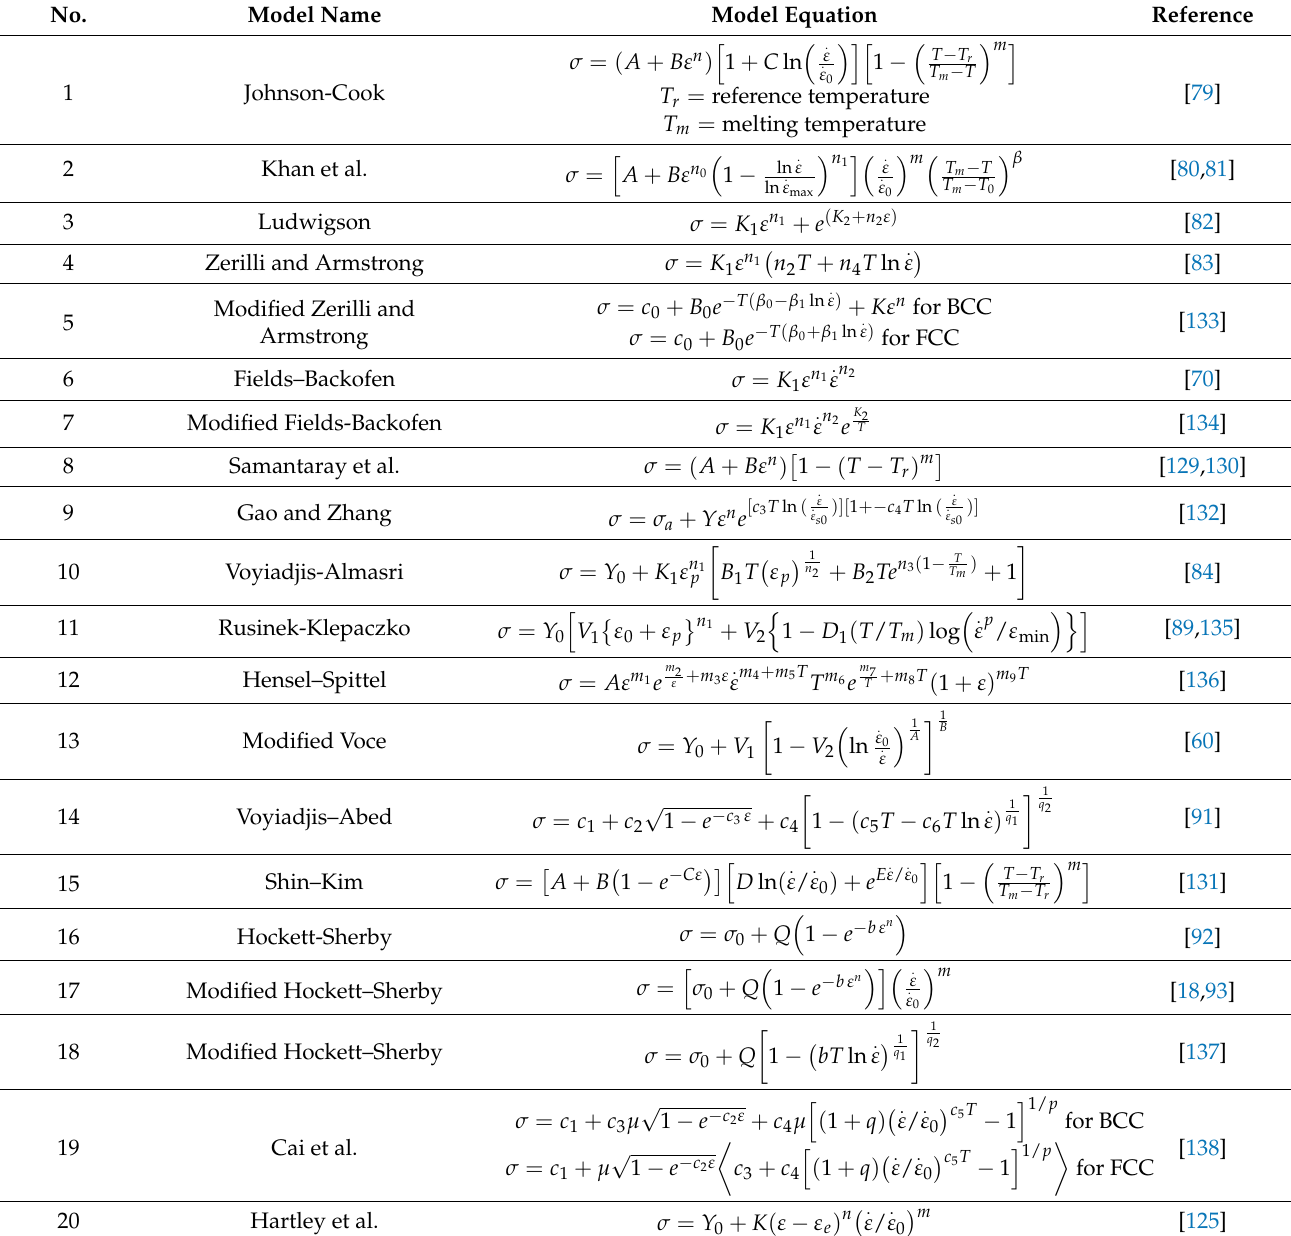
Table 7. Thermoviscoplastic models that can be potentially applied to cold